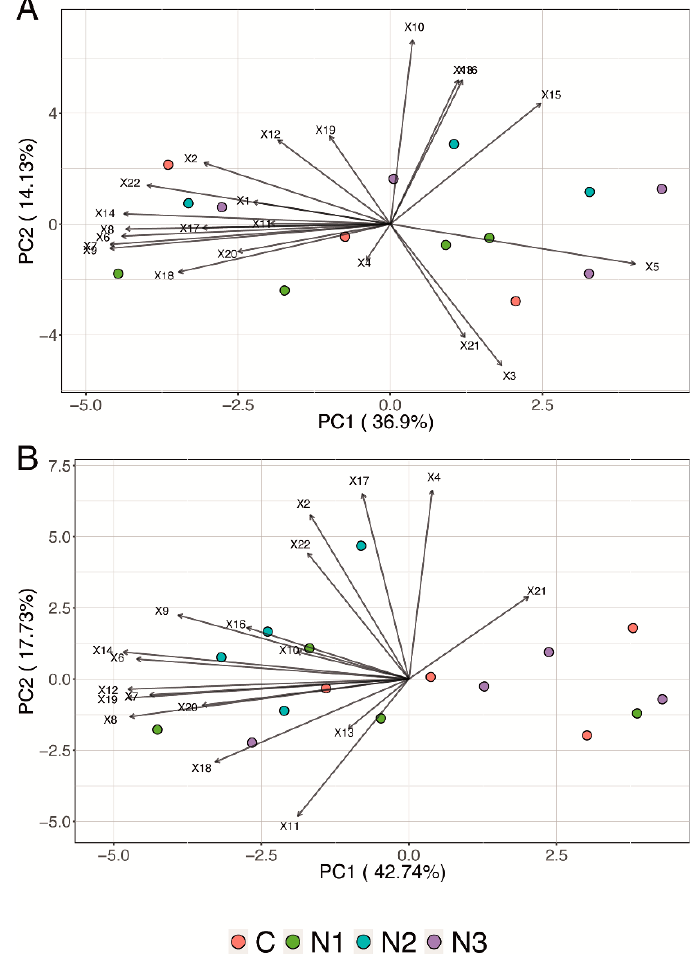
Figure 4. Principal component analysis (PCA) of the volatile compounds dataset. The two scatterplots represent the modification of Pinot gris berries volatile profile harvested from plants subjected to different fertilization practices (N1: granular NH 4 NO 3 applied to the soil; N2: U-ACP applied to the soil; N3: granular NH 4 NO 3 to the soil + foliar U-ACP; C: control with no N fertilization) in the production years 2020 ( A ) and 2019 ( B ). X1–X22, volatile compounds are described in Supplementary Table S1.